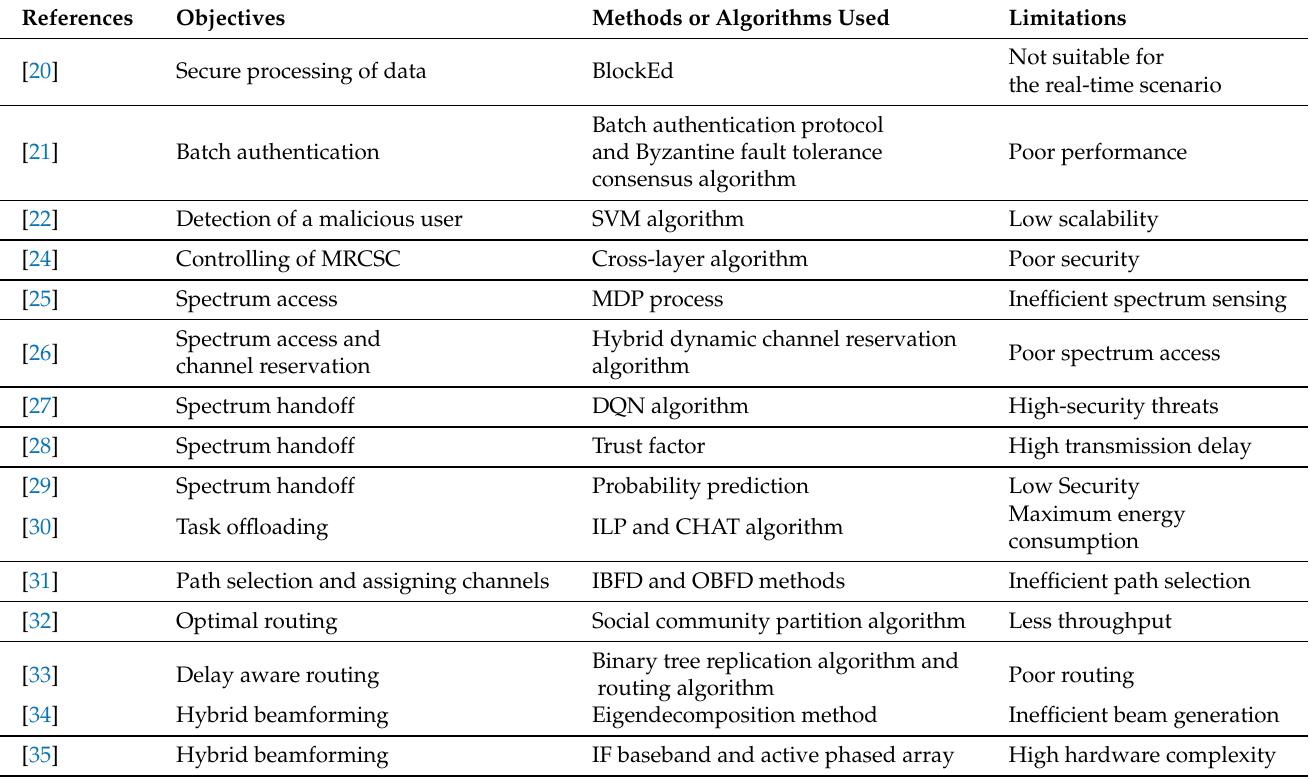
Table 2. Summary of related